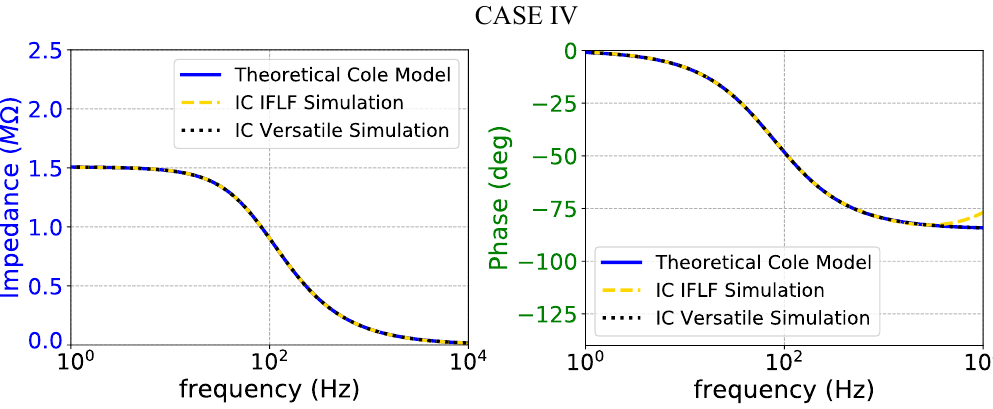
Figure 17. Impedance magnitude ( left ) and phase response ( right ) of the case III fractional-order electrode model.